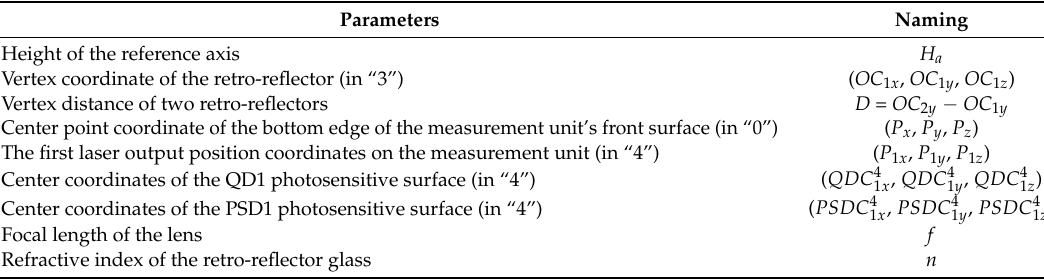
Table 2. The naming of